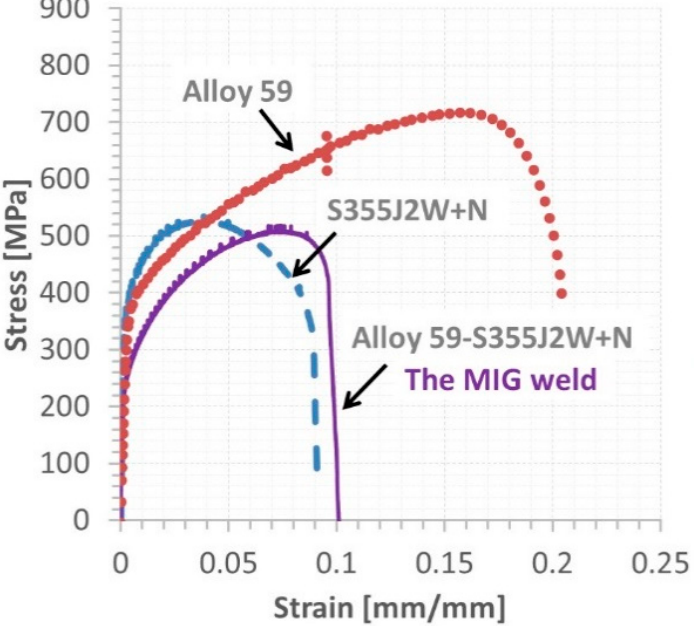
Figure 18. Engineering tensile characteristics of the Alloy 59, S355J2W+N steel and their MIG joint from Figures 13–15.